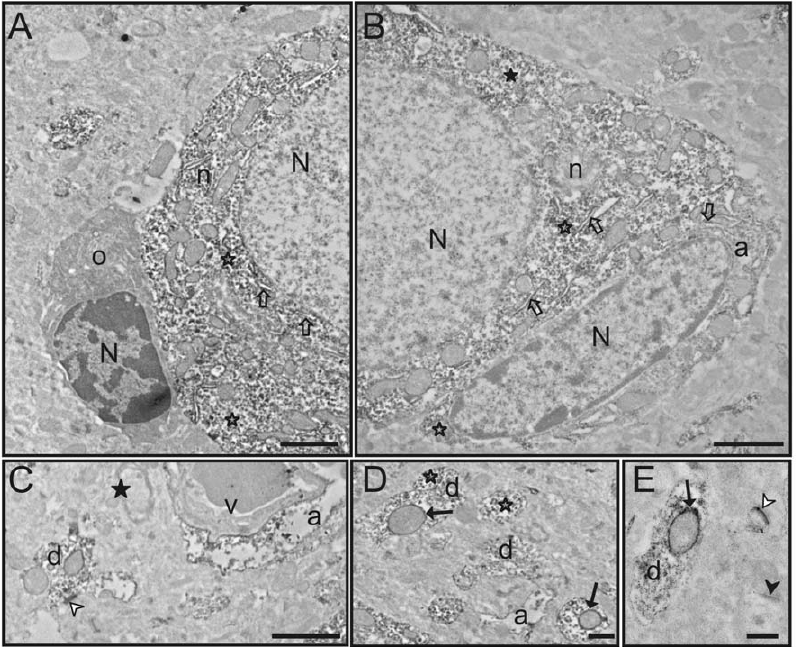
Figure 5. Electron microscopy images of GSK3 b labeling in the piriform cortex. A) Partial image of a neuron (n) with an adjacent oligodendrocyte (o). The cytoplasm of the neuron presents abundant and strongly labeled rough endoplasmic reticulum (outlined arrows) and free ribosomes (outlined stars). In contrast, the adjacent oligodendrocyte (o) is completely devoid of immunostaining. The electron-dense appearance of the oligodendrocyte cytoplasm is not due to GSK3 b labeling [this is the typical appearance of an unlabeled mature oligodendrocyte cytoplasm]. B) Image of a labeled astrocyte (a) adjacent to a labeled neuron (n). Both the small cytoplasm of the astrocyte and the abundant cytoplasm of the neuron present labeling in the rough endoplasmic reticulum (outlined arrows) and in free ribosomes (outlined stars). C) A labeled astrocytic process (a) is surrounding an unlabeled blood vessel (v). The basement membrane and endothelial cell are devoid of labeling. A dendrite (d) and a postsynaptic density (white arrowhead) are also labeled. Note that myelin is completely devoid of immunostaining (black star). D) Detail image of a GSK3 b dendrite (d). Strongly labeled mitochondria (black arrows) and free ribosomes (outlined stars) are also seen. E) Examples of two synapses. One is a GSK3 b -labeled synapse (white arrowhead), while the other synapse is unlabeled (black arrowhead). Note the rich cytoplasmic stain in the dendrite (d) and the staining of the outer mitochondrial membrane (black arrow). [N: nucleus; Scale bars: 2 m m in A–B; 1 m m in C–E]